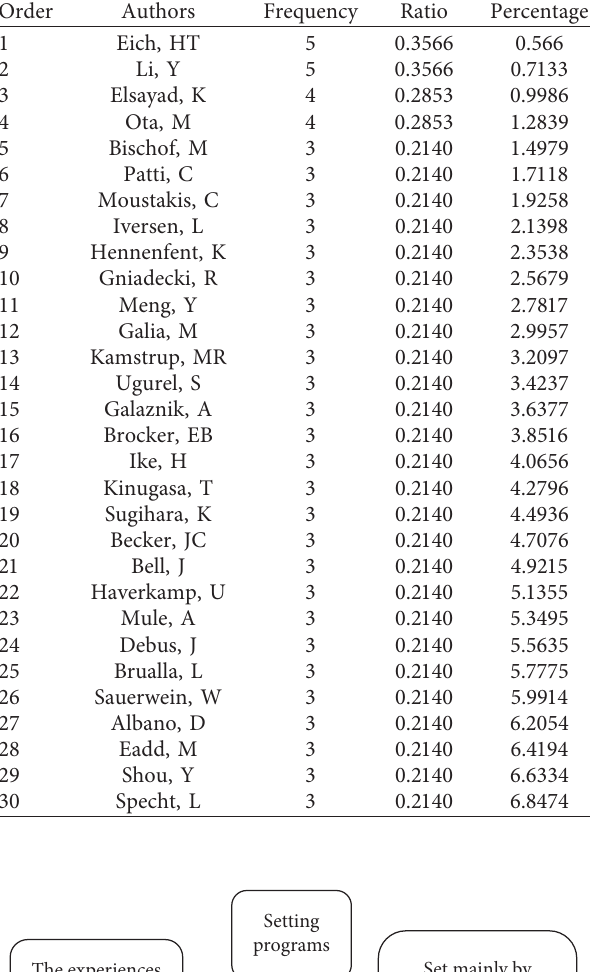
Table 4: The list of countries.